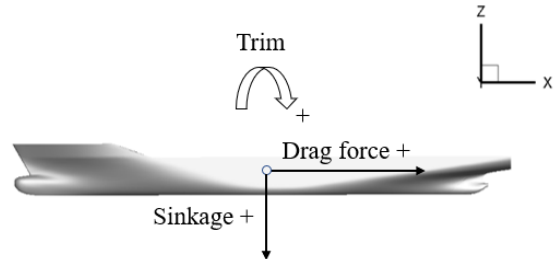
Figure 9. The directions of the drag force, trim angle and sinkage.